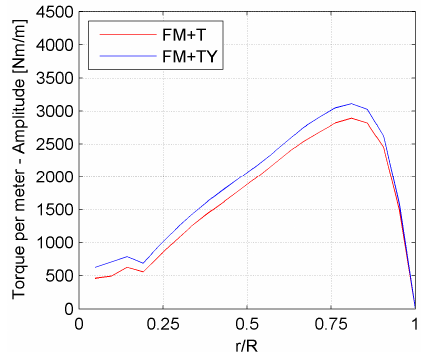
Figure 19. Amplitude of the torque oscillation as a function of the span: FM + T vs. FM + TY.